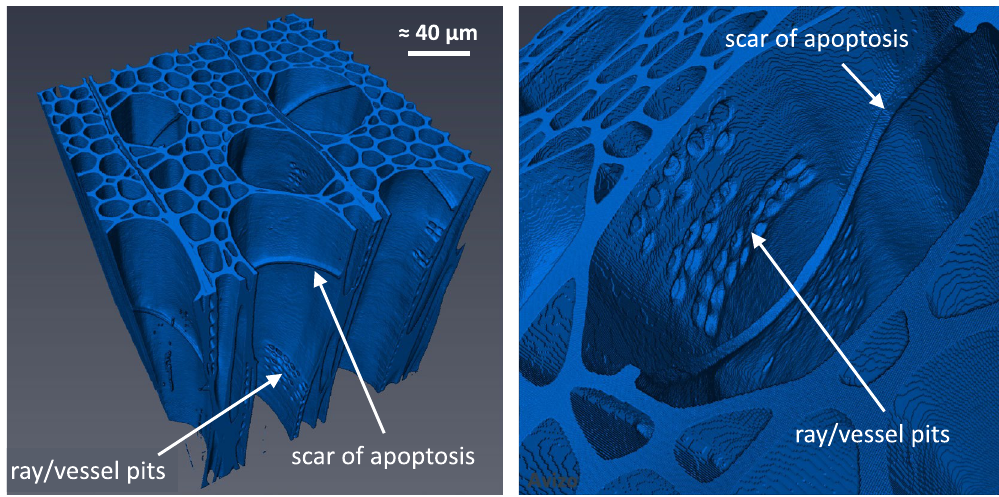
Figure 5. Specific features of poplar anatomy, revealed by a high resolution scan (LaB6 filament of the X-ray nano-source, ca. 8 h scan, 0.3 µ m of voxel size).